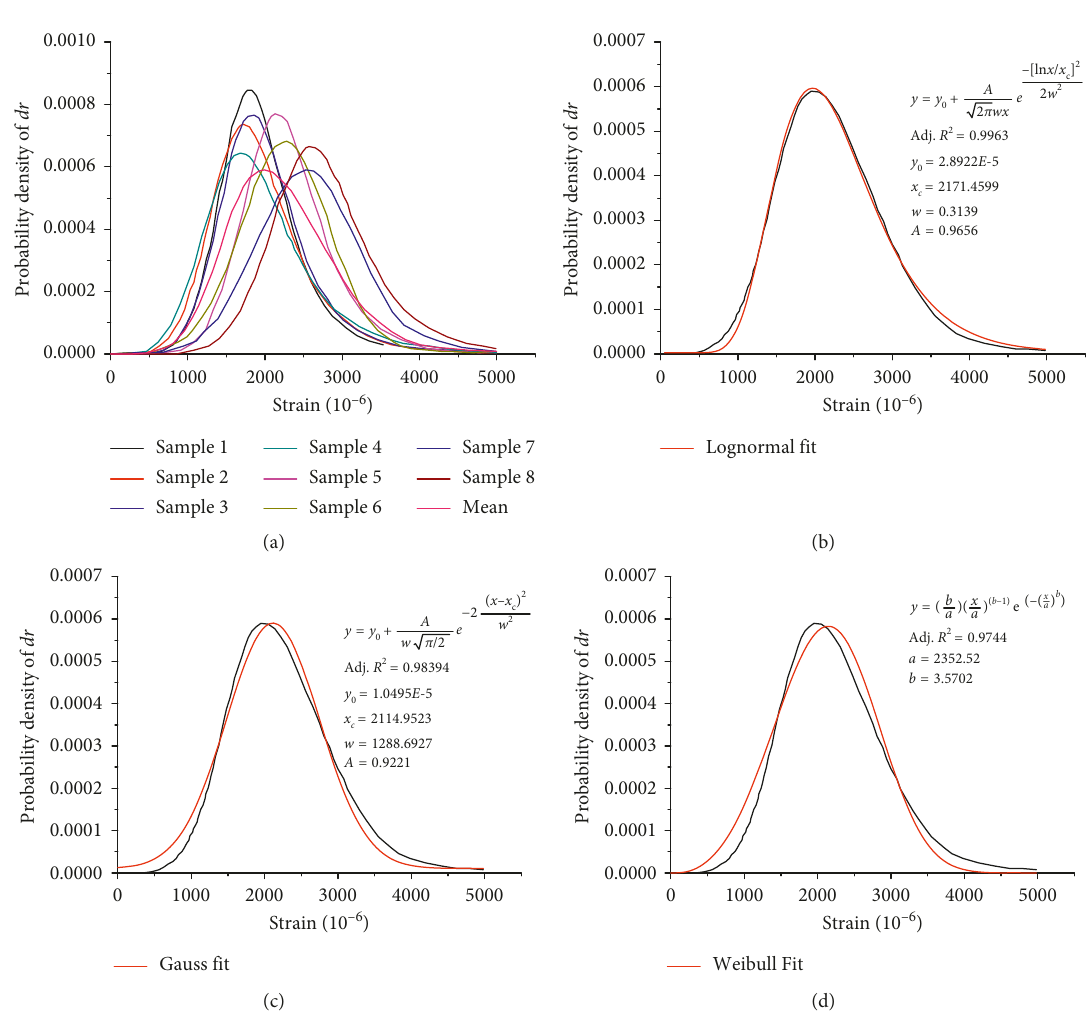
Figure 7: Stochastic probability density of micro-yield-damage thresholds of SCC samples under compression (a), and fitting of the mean probability density of the thresholds